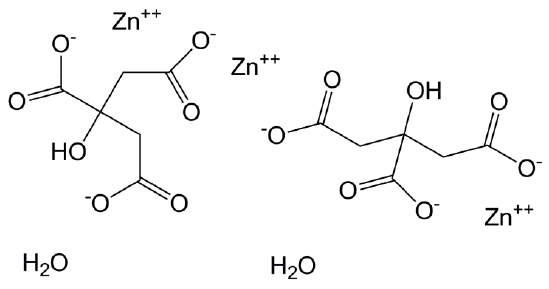
Figure 4. Dissociation mechanism that zinc citrate releases electric charges after it is dissolved in